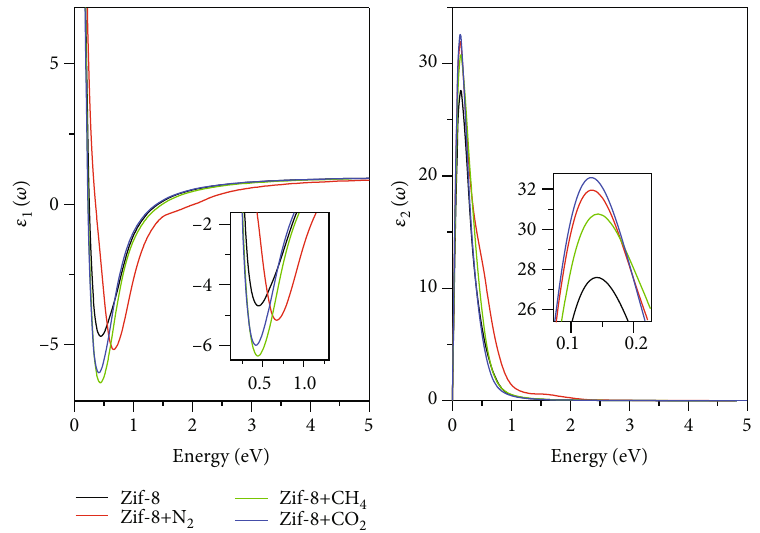
Figure 6: Real ε